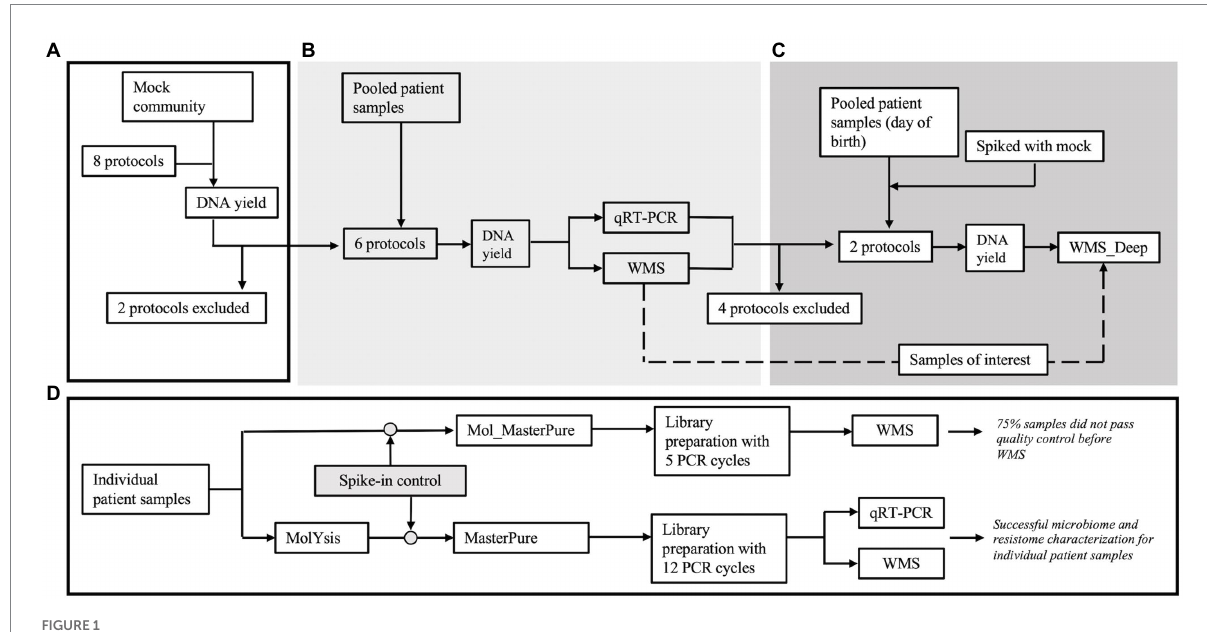
FIGURE 1 Overview of the experiments. (A) Eight protocols were initially tested with Mock community samples (Zymo, D6300) to evaluate loss of DNA during processing. Two protocols were excluded prior to processing clinical samples. (B) Three pools (A, B, and C) were created by blindly pooling six 2 ml samples from premature infants for each pool. Six aliquots (2 ml each) from each pool were processed according to the remaining six protocols. (C) After reviewing results, four protocols were excluded and an additional pool was created using six samples from premature infants, obtained right after birth (Pool D). Six aliquots (2 ml) from this pool were processed according to the remaining two protocols. Two of the aliquots were spiked with mock community. (D) The most promising protocol (Mol_MasterPure) was further tested on individual patient